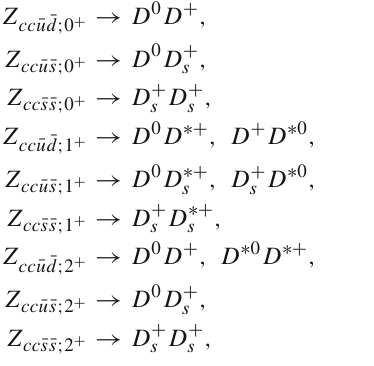
within uncertainties make